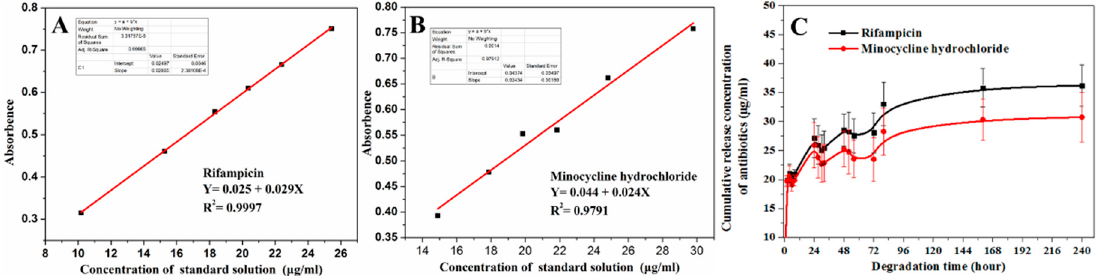
Figure 9. Standard curves of ( A ) rifampicin and ( B ) minocycline hydrochloride; ( C ) cumulative release concentration of antibiotics during degradation time.